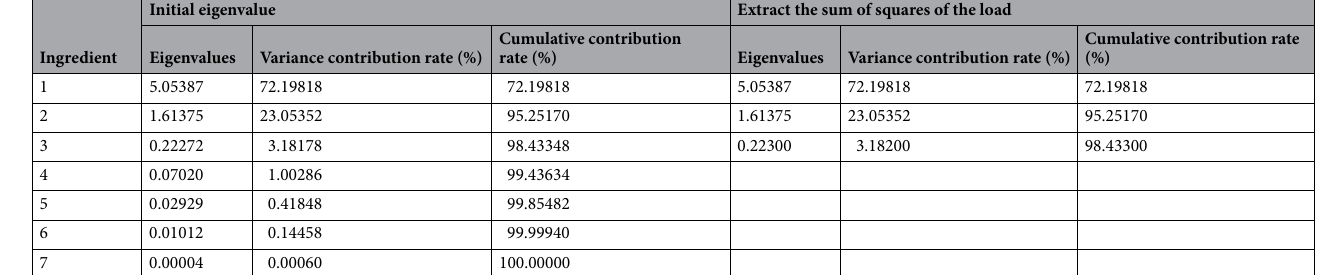
Table 2. Principal component analysis of meteorological factors in Hancang river basin.